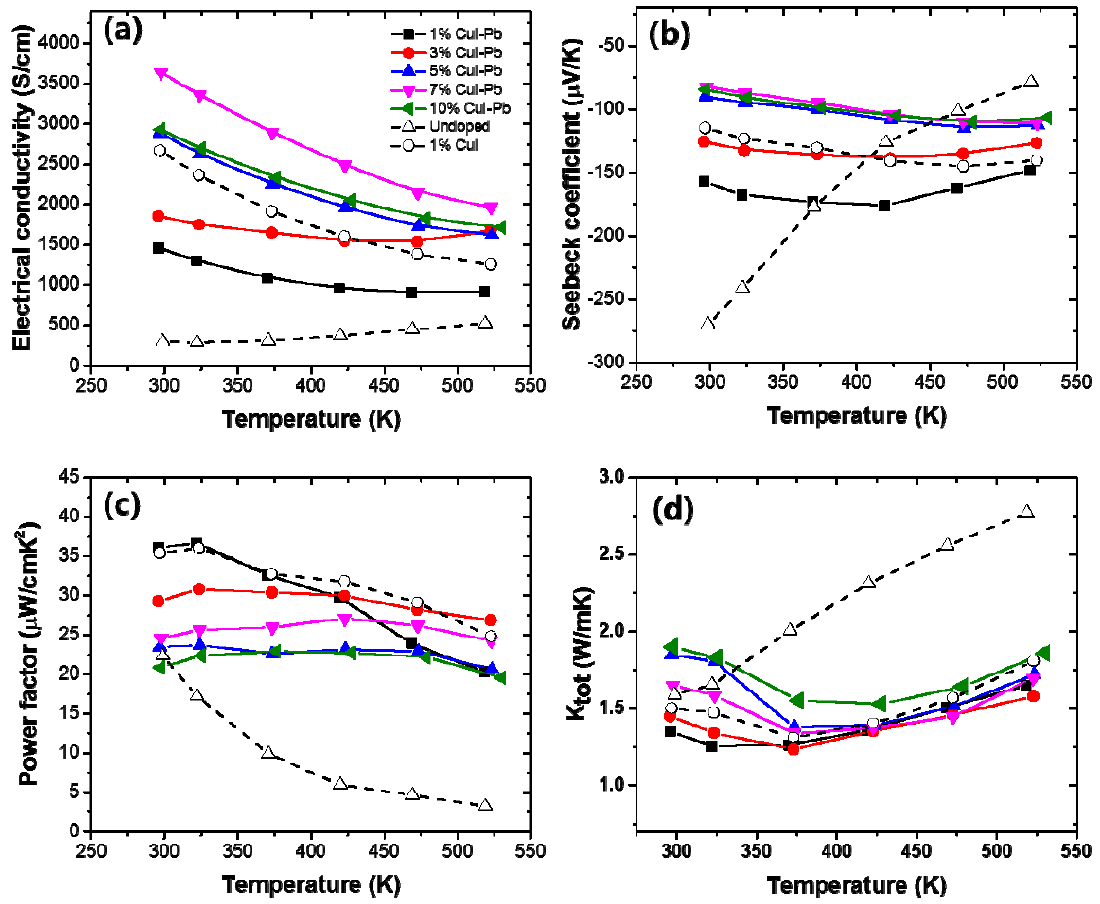
Figure 4. The temperature dependence of ( a ) electrical conductivity ( σ ); ( b ) Seebeck coefficient ( S ); ( c ) power factor, and ( d ) thermal conductivity of x % CuI-Pb co-doped Bi 2 Te 3 ( x = 0.01, 0.03, 0.05, 0.07, and 0.10).